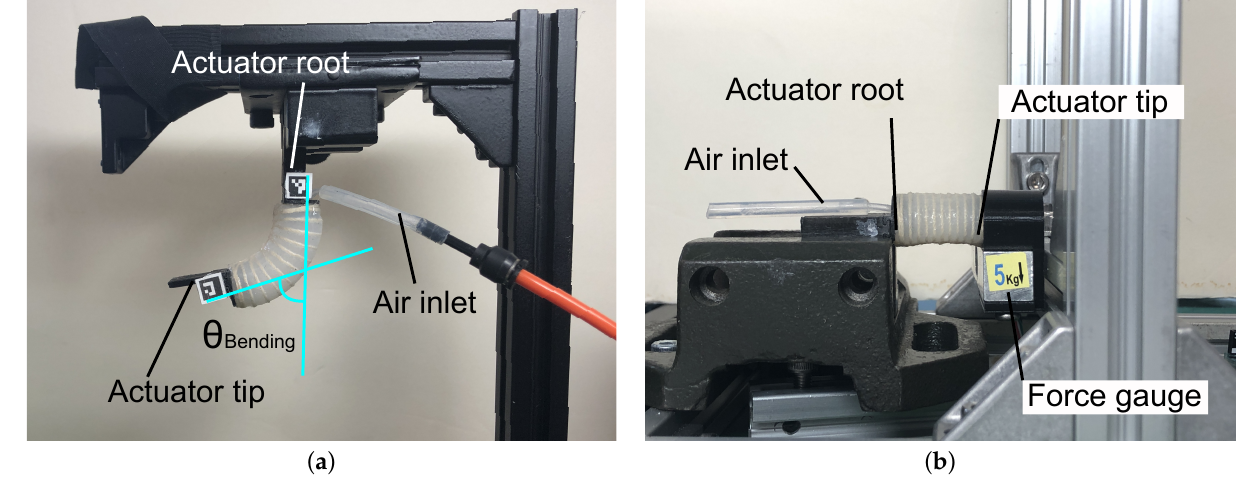
Figure 5. Experimental setup with only the actuator. ( a ) Bending angle; ( b ) tip force.